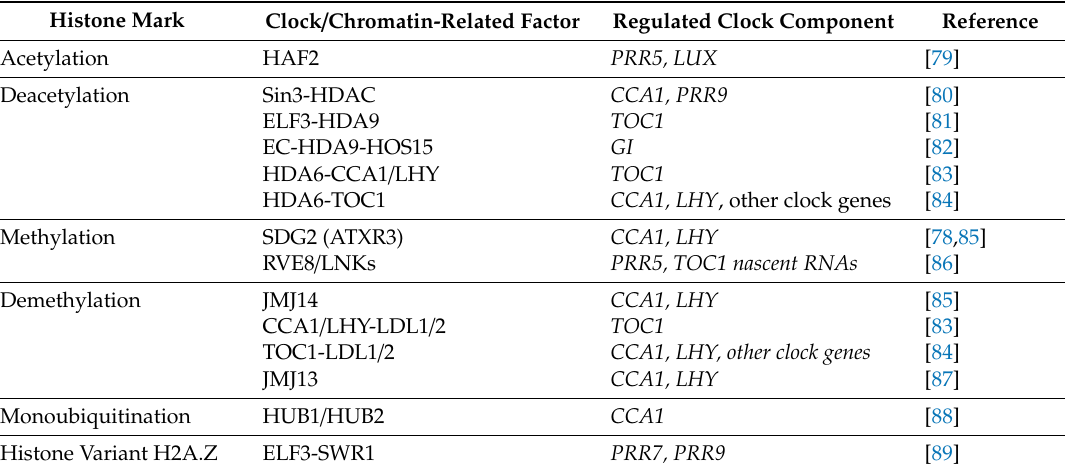
Table 1. List of the most recent findings connecting chromatin changes and circadian oscillator genes in